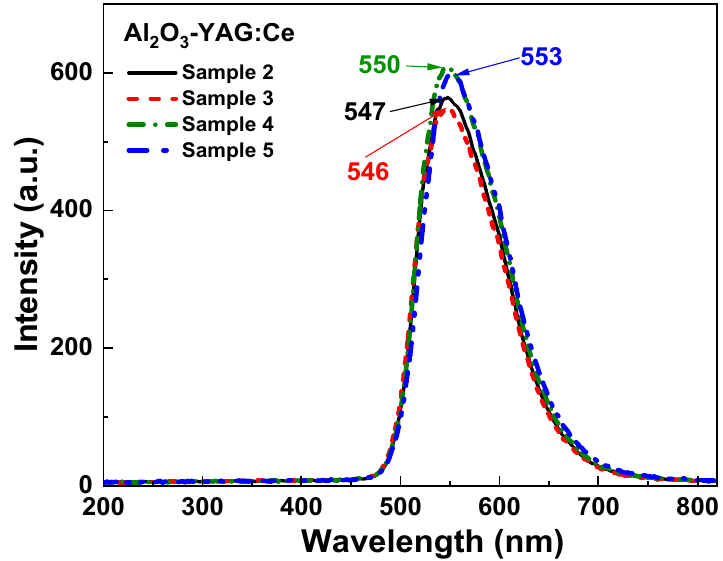
Figure 6. CL spectra of the (Al 2 O 3 -YAG):Ce eutectic samples under study.